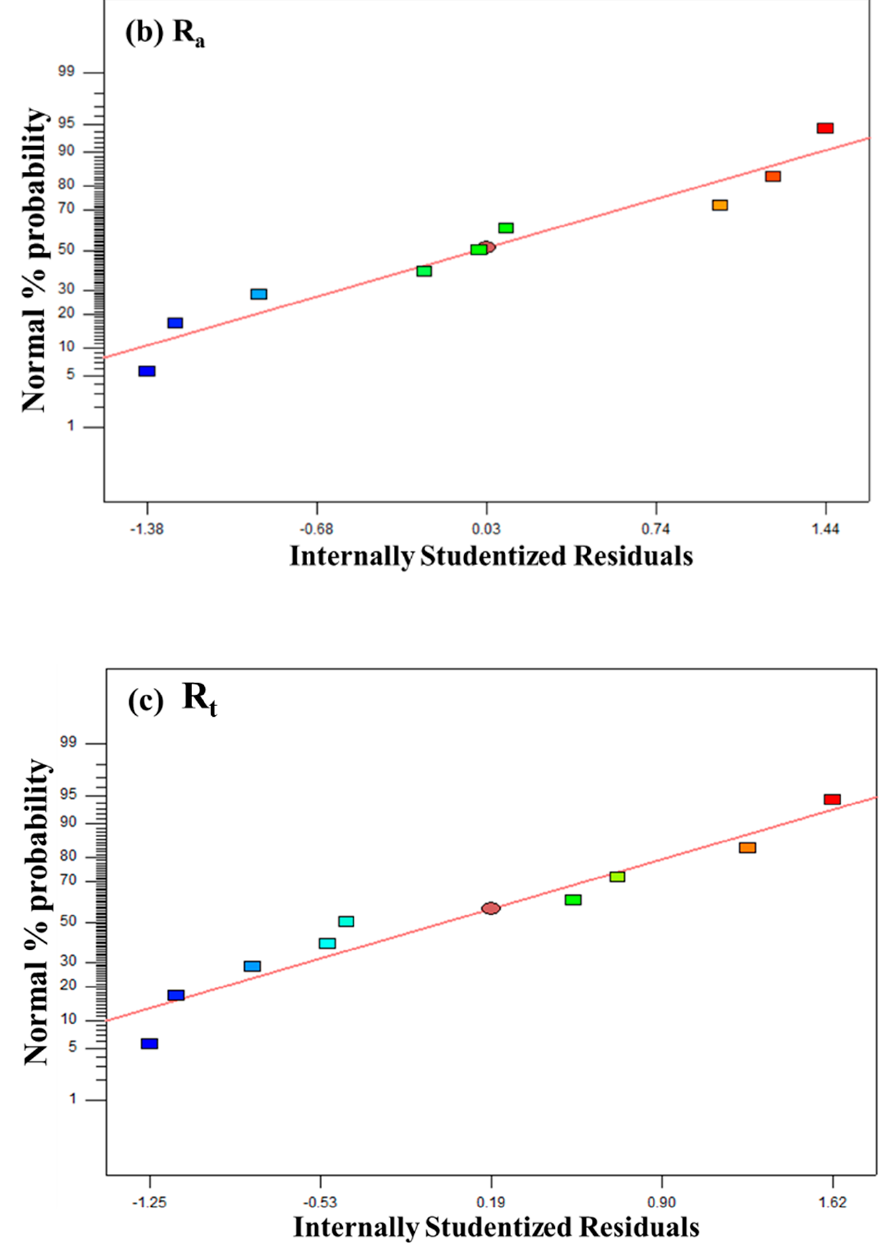
Figure A1. Normal graphs of residuals for considered responses: ( a ) volumetric gear cutting speed ‘VGCS’; ( b ) average surface roughness ‘Ra’, and ( c ) maximum surface roughness ‘Rt’. Table A1. Values of variable WTEM parameters for nine experimental runs and corresponding average values (i.e., rep- licates R1 and R2 ) of considered responses for miniature gear fabrication.